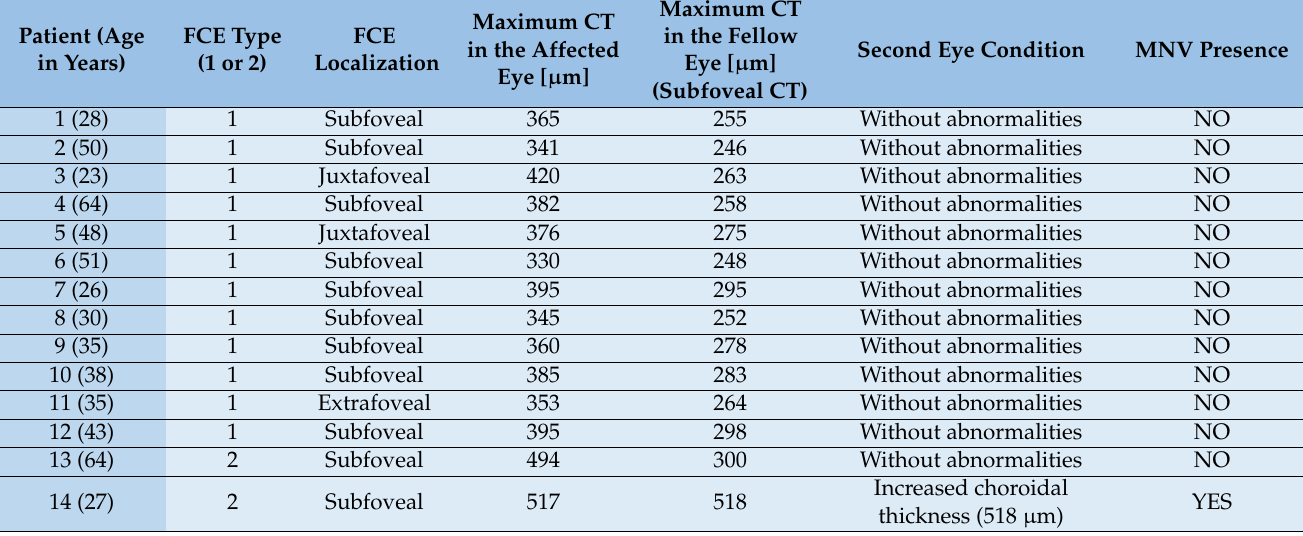
Table 2. FCE characteristics and fellow eye condition in the study